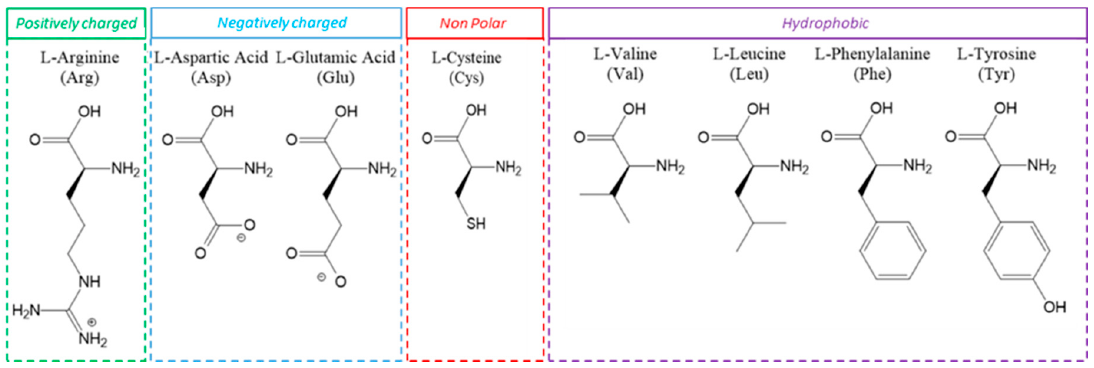
Figure 1. Chemical structure of the selected amino acids grouped according to the chemical characteristics of the side chain.